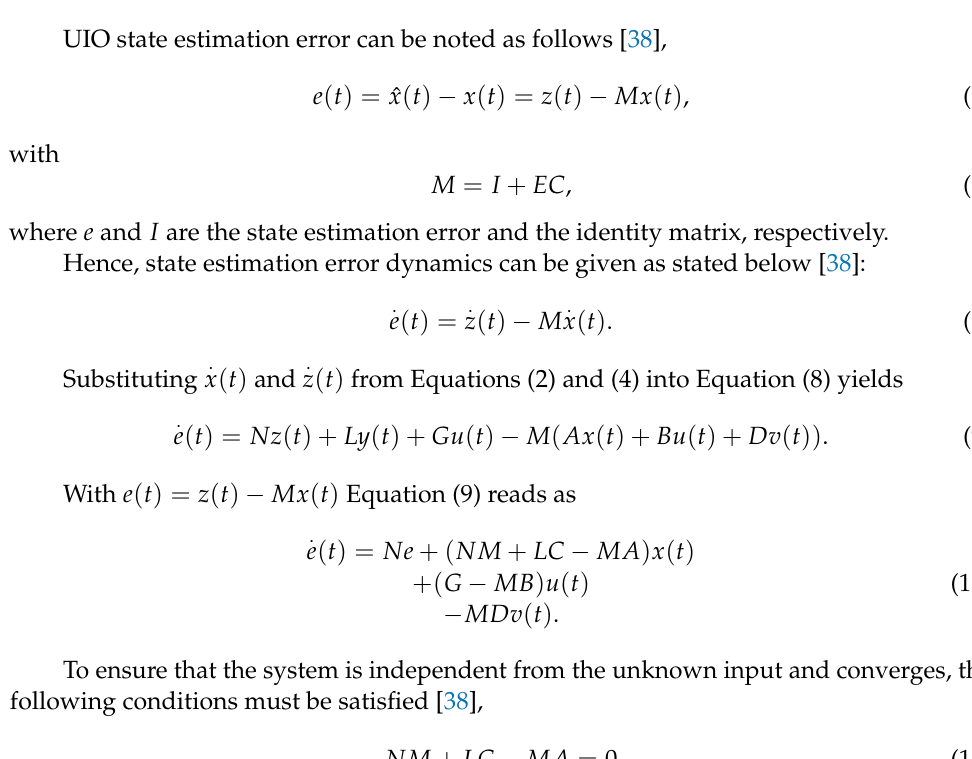
Figure 5. Structure of the unknown input